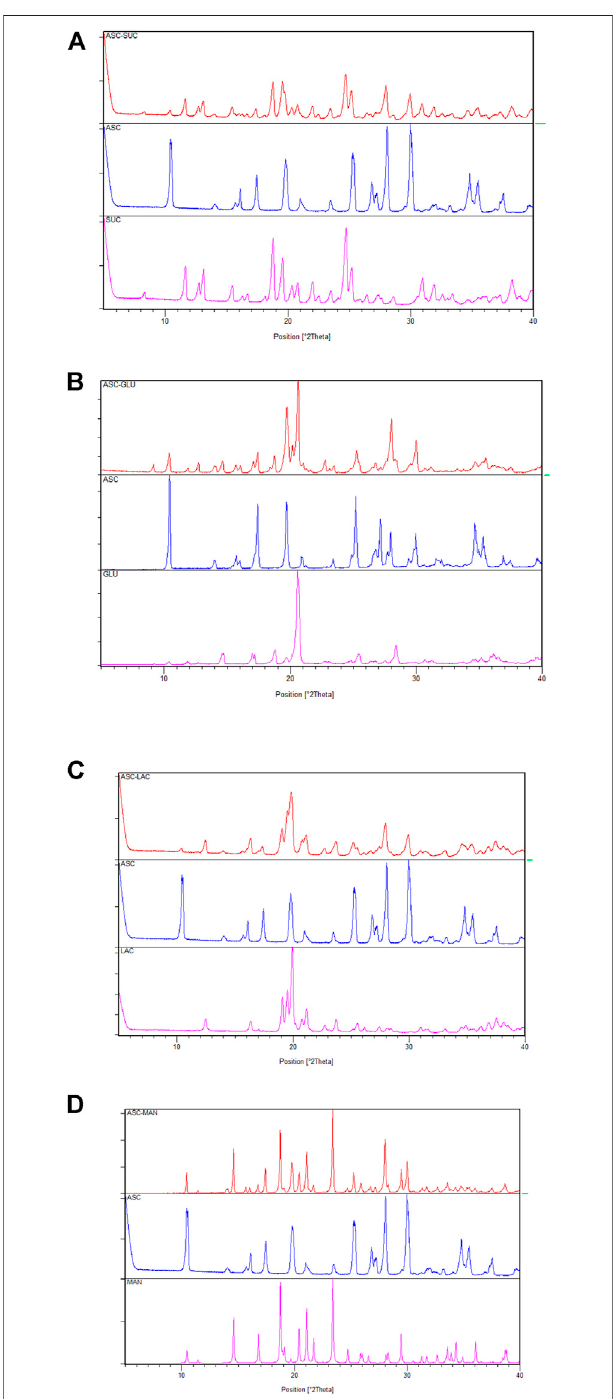
FIGURE 1 | Powder X-ray diffraction (PXRD) comparison (A – D) of the ascorbic acid + sugar (ground mixture) with the ASC and coformers indicate physical mixture of individual components and there is no strong hydrogen bonding interactions between